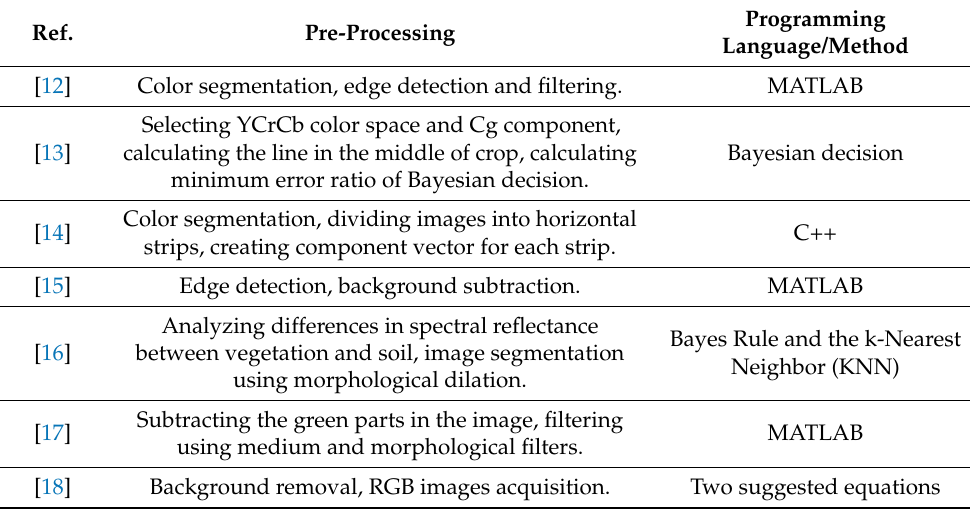
Table 1. Weed-detection-related work using image processing techniques. Ref.